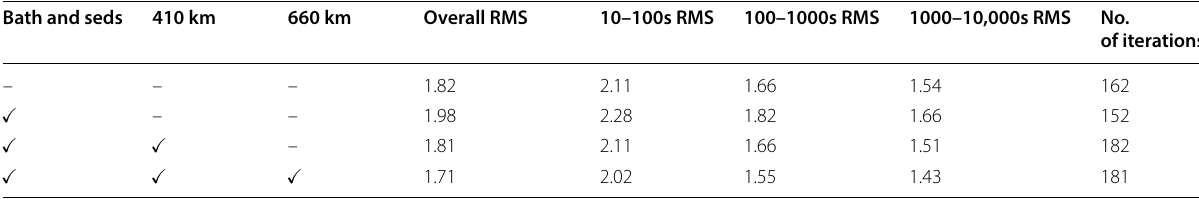
Table 1 Information that is included in the prior model for four different inversions